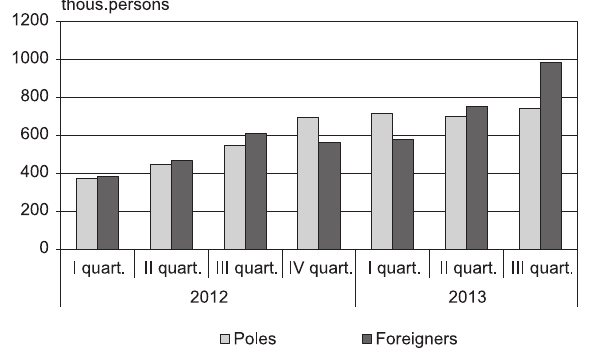
Fig. 2. Border traffic of Poles and foreigners on the border of Poland and the Kaliningrad Oblast of the Russian Federa- tion in 2012 and the first three quarters of 2013 Source: own study based on: